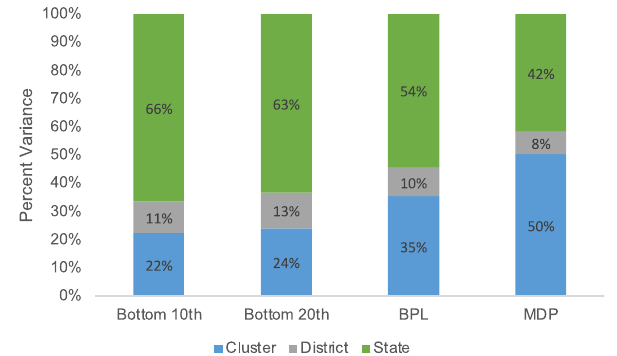
Fig. 3 Bar graph showing the geographic variance partitioning by clusters, districts, and states for the four measures of poverty.